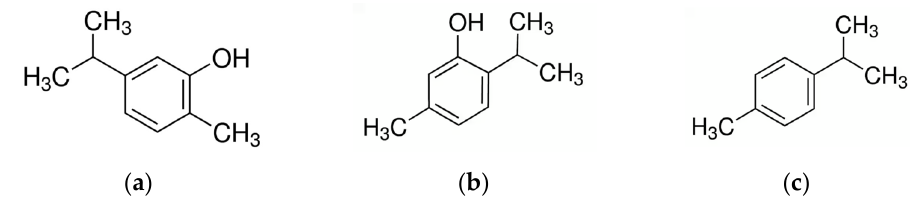
Figure 2. Main components of Origanum EOs. ( a ) Carvacrol; ( b ) Thymol; ( c ) p-Cymene. Carvacrol and thymol are structural isomers with a hydroxyl group positioned at different positions relative to the phenolic ring and represent ones of the most common and well-known terpenoids, namely terpenes with added oxygen molecules or that have had their methyl groups moved or removed by specific enzymes [106].